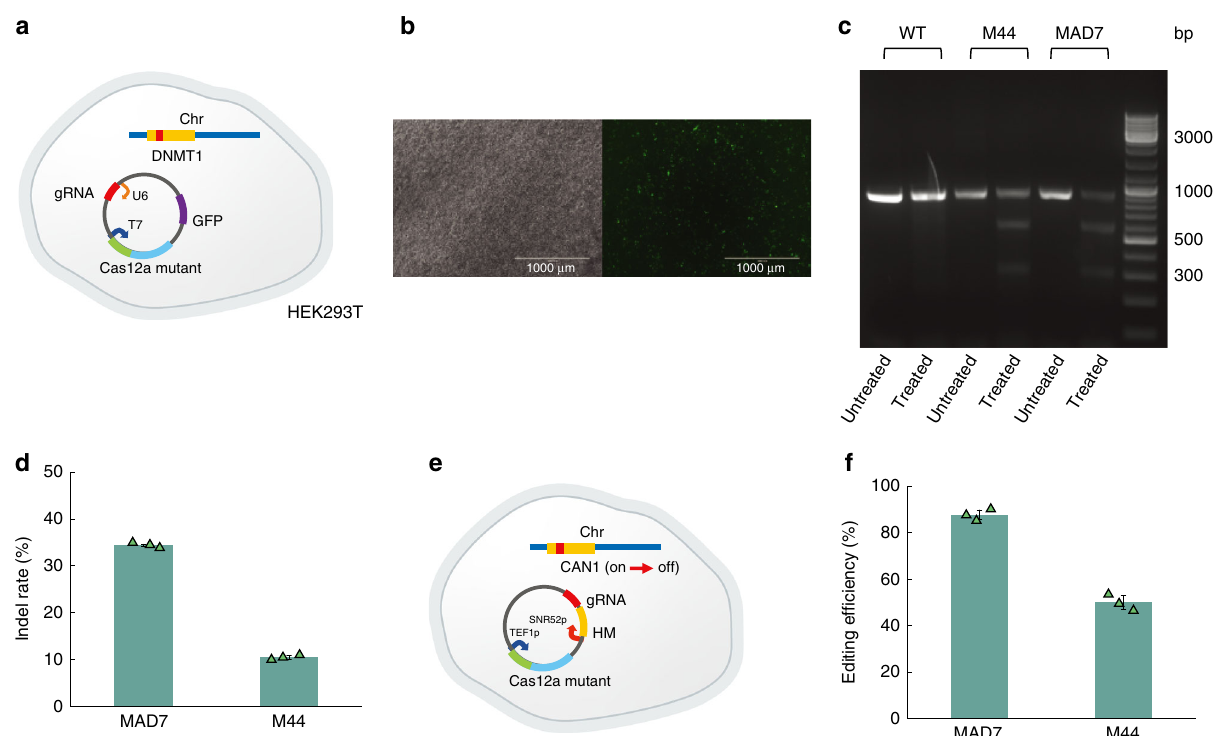
Fig. 6 Chimeric nucleases enable genome editing in eukaryotic cells. a Genome editing in mammalian cells (HEK293T) using chimeric Cas12a-type variants. We constructed a plasmid expressing the M44 (or MAD7) nuclease (with T7 promoter), a single crRNA (with U6 promoter), and GFP. b Pictures of HEK293T after transfection. The H3K293T cells were transfected with the plasmid containing the M44 nuclease and GFP. Micrographs were taken under cool white light (left) or fl uorescent light (right). c The T7E1 assay 52,58,59 was performed on cells that were expressing GFP and isolated by fl uorescence-activated cell sorting. Untreated means the PCR products without T7 endonuclease treatment. Treated means the PCR products with T7 endonuclease treatment. d The indel rate of MAD7 and M44. The calculation was made using the formula shown in the methods section. e Genome editing in yeast ( S. cerevisiae BY4741) using chimeric Cas12a-type variants. We constructed a plasmid containing the M44 (or MAD7) nuclease